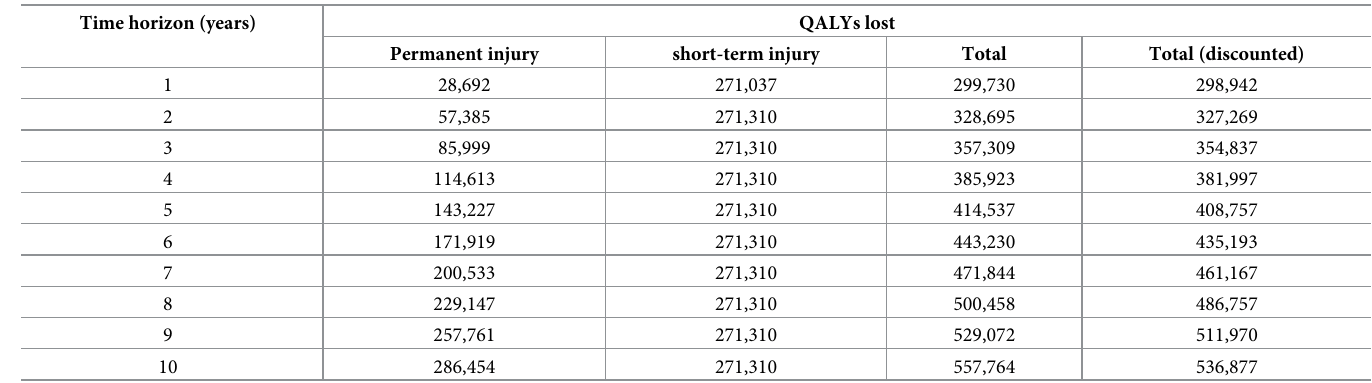
Table 2. Estimates of total QALYs lost over 1 and 10 year time horizons.